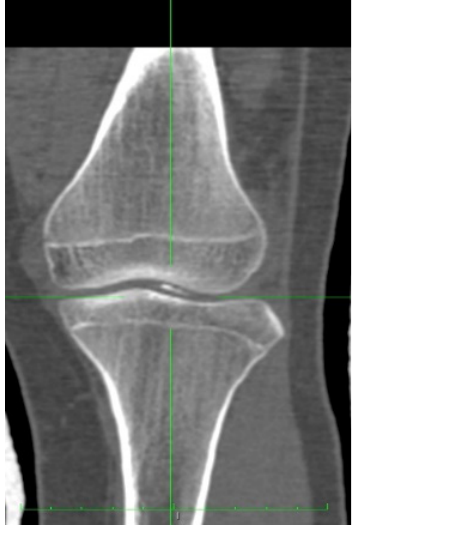
Figure 4. CT scans of the injured knee clearly showing the fractured fragment; ( a ) AP view and ( b ) L view.